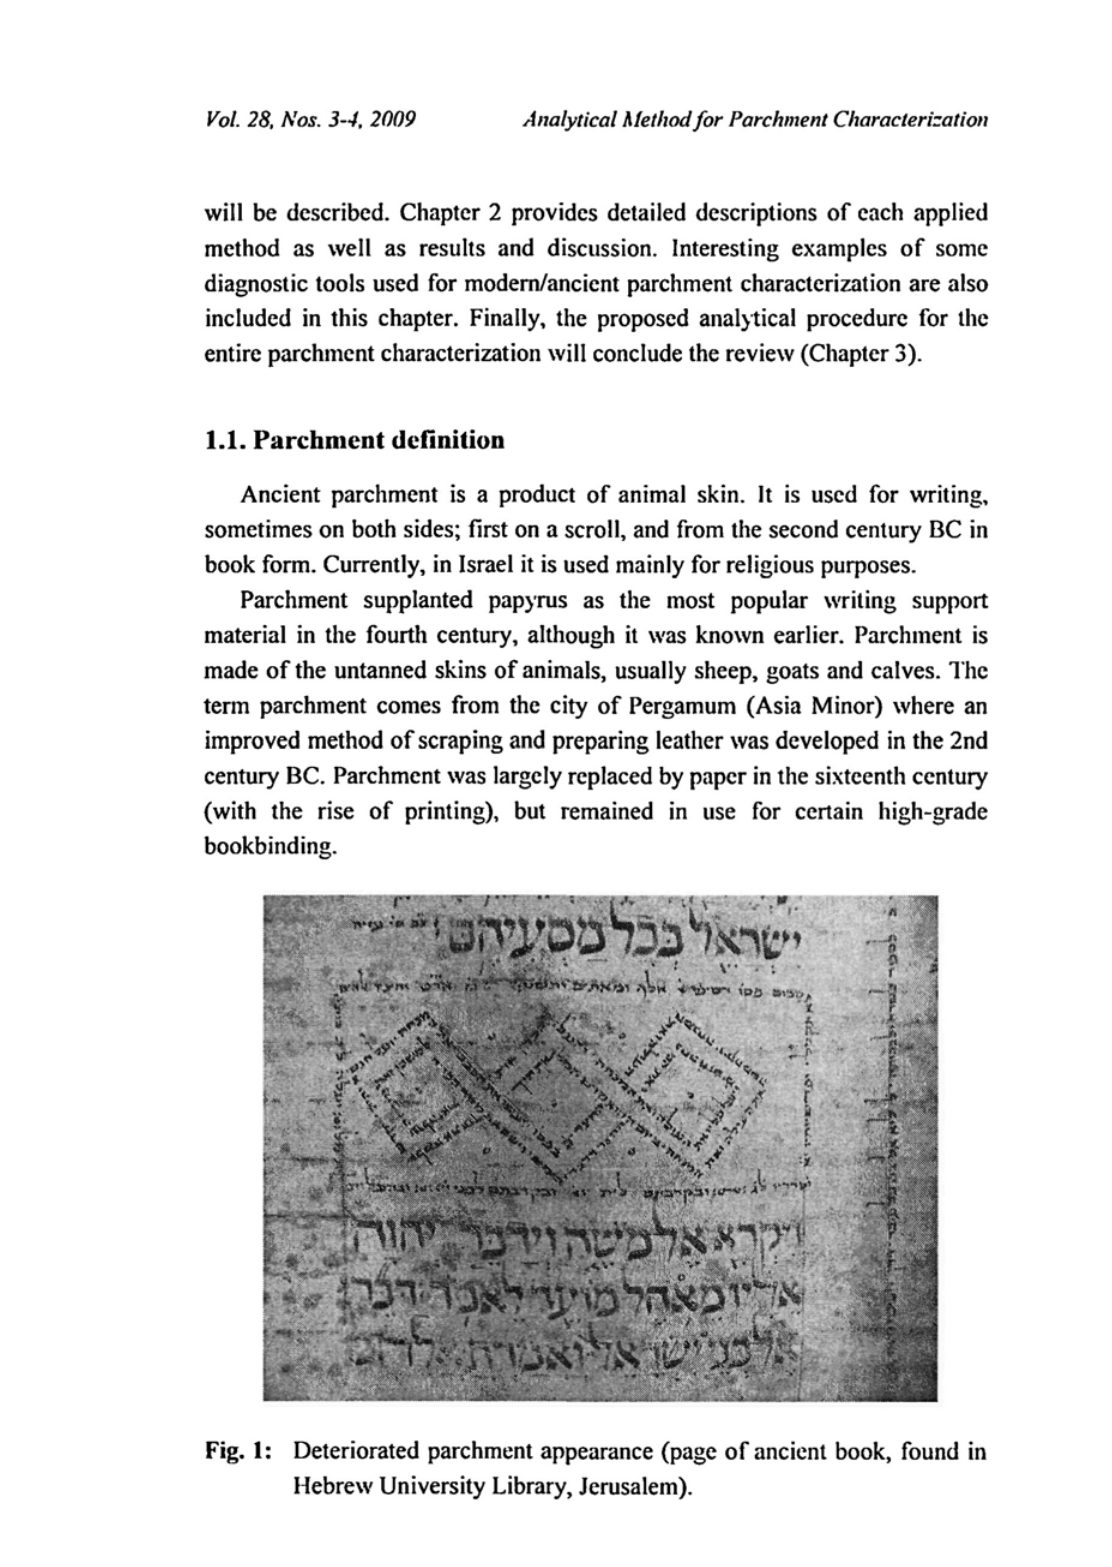
Fig. 1: Deteriorated parchment appearance (page of ancient book, found in Hebrew University Library,